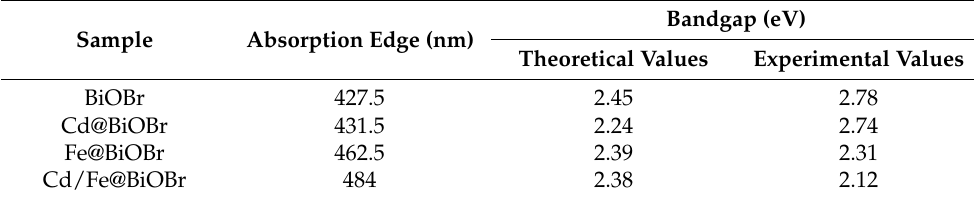
Table 1. Absorption edges and band gaps for